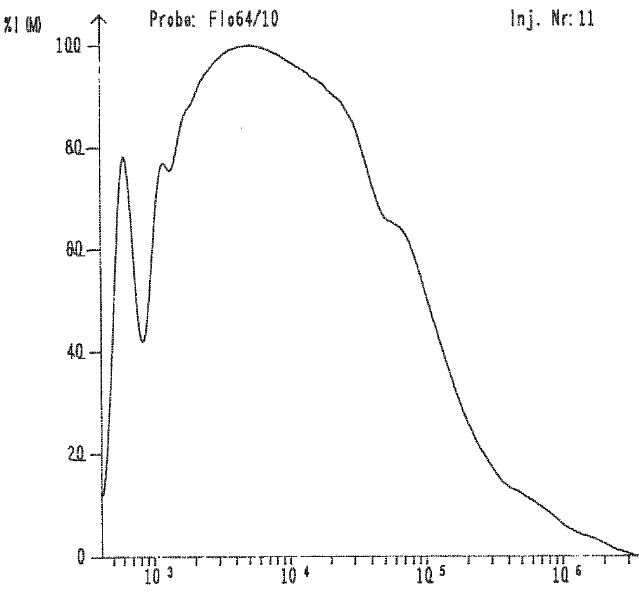
Figure 1. GPC-trace of the polymer obtained from the polymerization of 1-methyl-2-